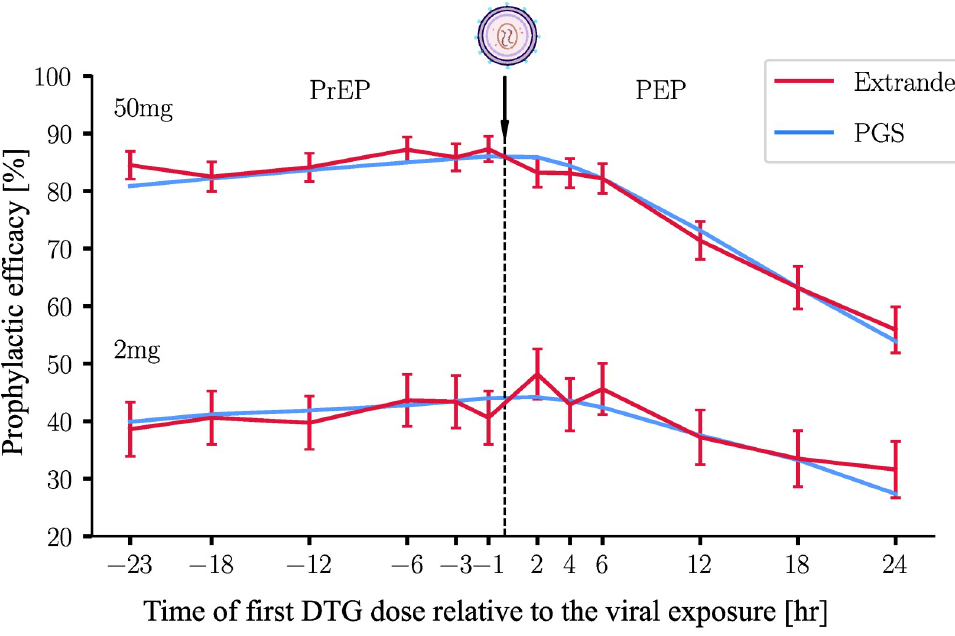
Fig 4. Prophylactic efficacy for PrEP and PEP computed by EXTRANDE and the new methods. 2 mg (lines below) and 50 mg (lines above) DTG were ingested for three days, respectively. The extinction probabilities were computed by EXTRANDE and PGS, for a representative individual with pharmacokinetic parameters k a = 2.24h − 1 , V p / F bio = 0.73 L, Q / F bio = 0.0082 L/h, CL / F bio = 0.85 L/h and V c / F bio = 17.7 L. The prophylactic efficacy was computed using Eq (1) for initial state Y 0 = [1, 0, 0] T (exposure to a single virus particle). The X-axis represents the timing of the first DTG dose relative to the virus challenge, which is marked by the arrow. EXTRANDE was run 10 000 times for each condition. The error bars denote the 95% confidence bounds for the ensemble estimate, computed using the Greenwood’s formula [42].